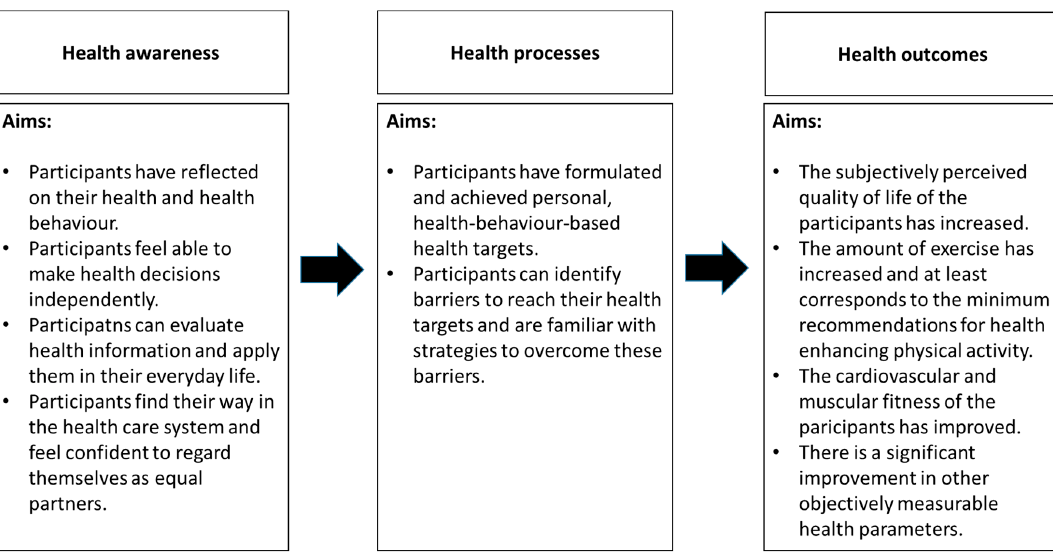
Figure 1. Health aims in different dimensions.